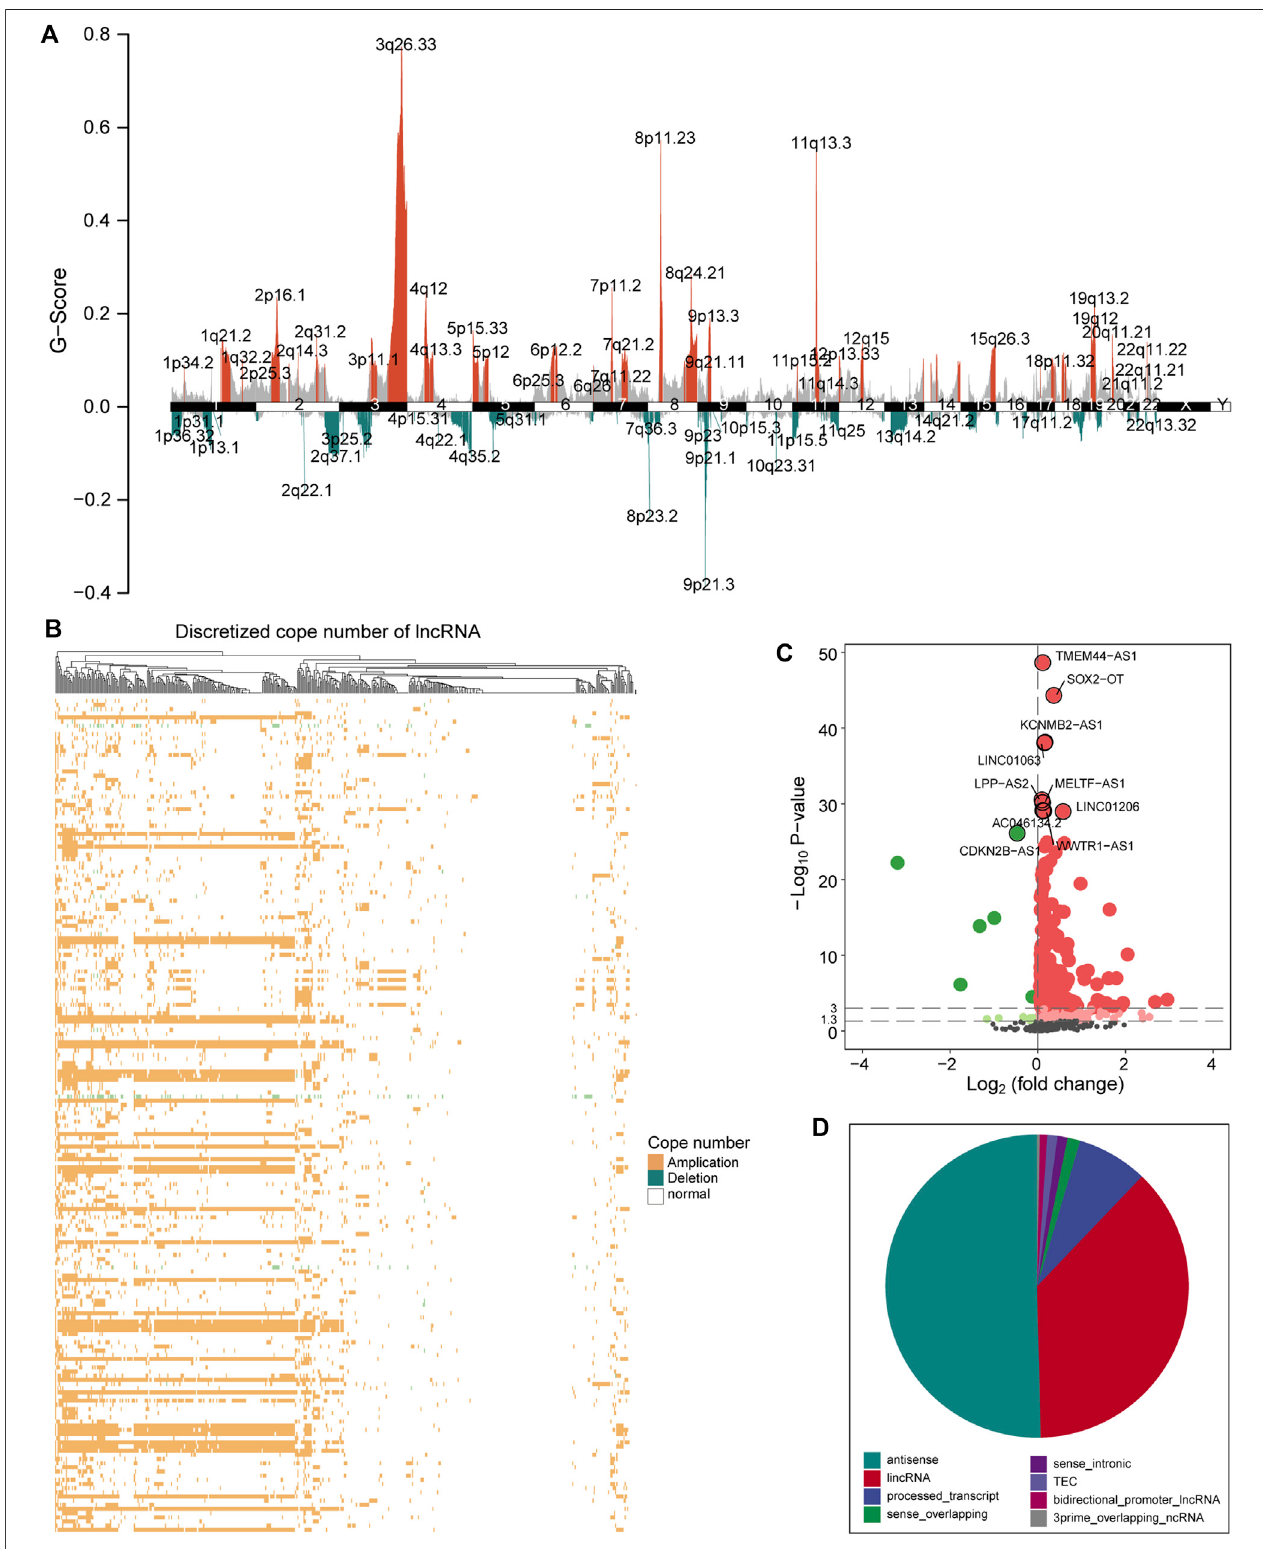
FIGURE1| Aglobal viewofCNV for LUSC. (A) Thegraph shows the distribution ofthe copy number amplitude on thegenomefor LUSC. The ordinate represents G -score, and the abscissa is the position of 22 homologous chromosomes and two sex chromosomes. (B) The ampli fi cation and deletion of lncRNA copy number in